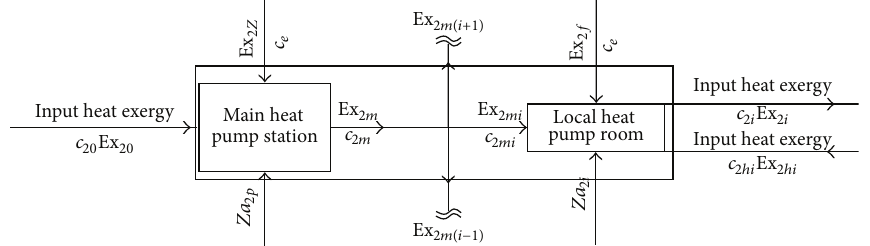
Figure 5: The thermoeconomics model of phase II project system.